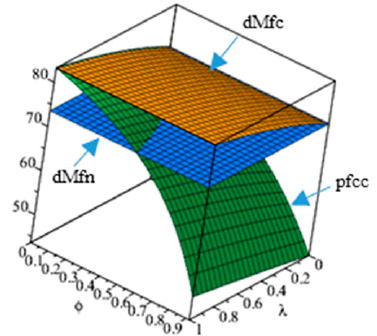
Figure 1. Effects of fairness concerns and profit‑sharing on wholesale prices.